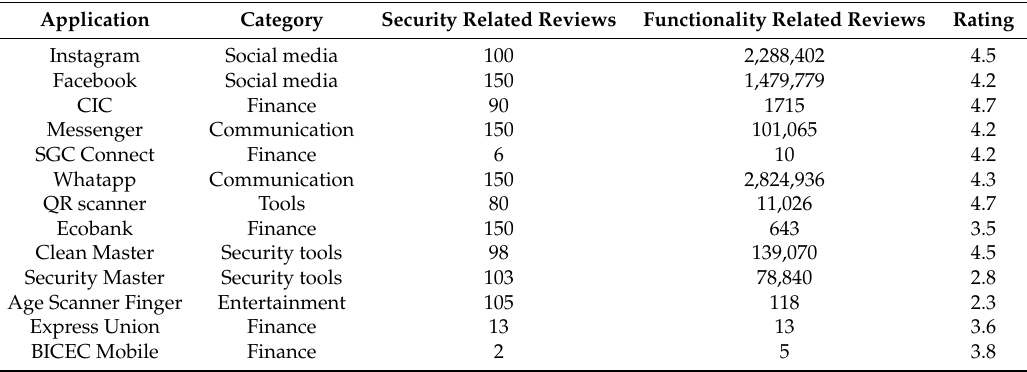
Table 4. Dataset